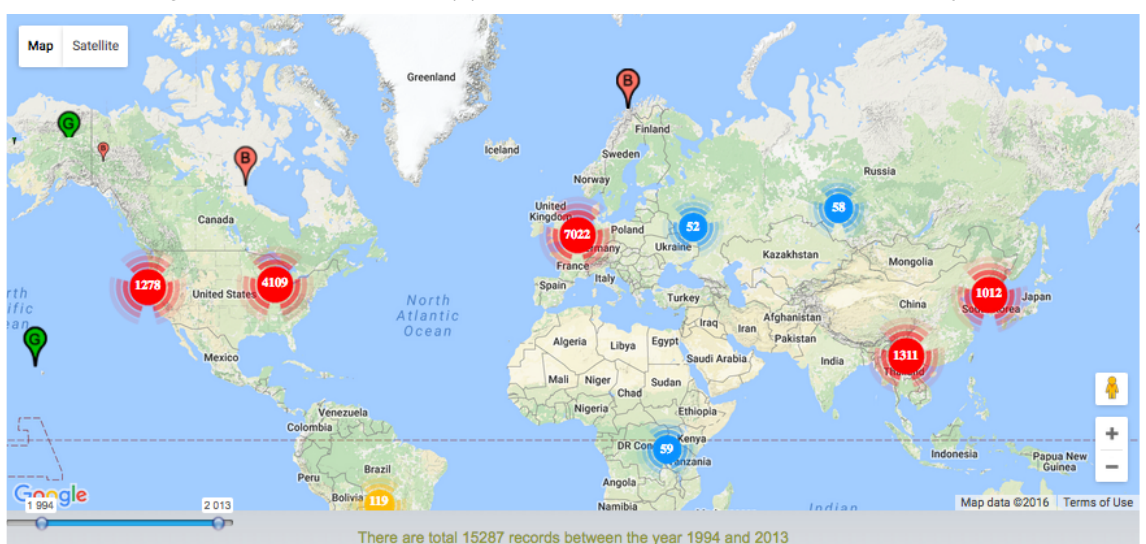
Figure 2: Geographic locations of biological databases and tools (over the years 1994-2013).